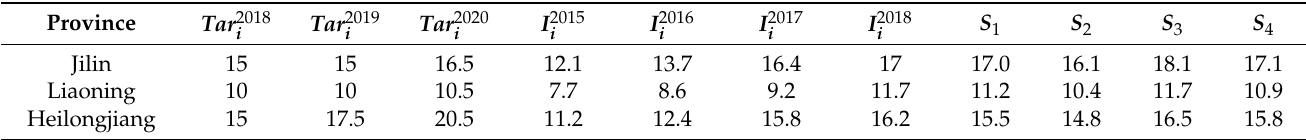
Table 3. Flexibility modification scenarios of Northeast China 1